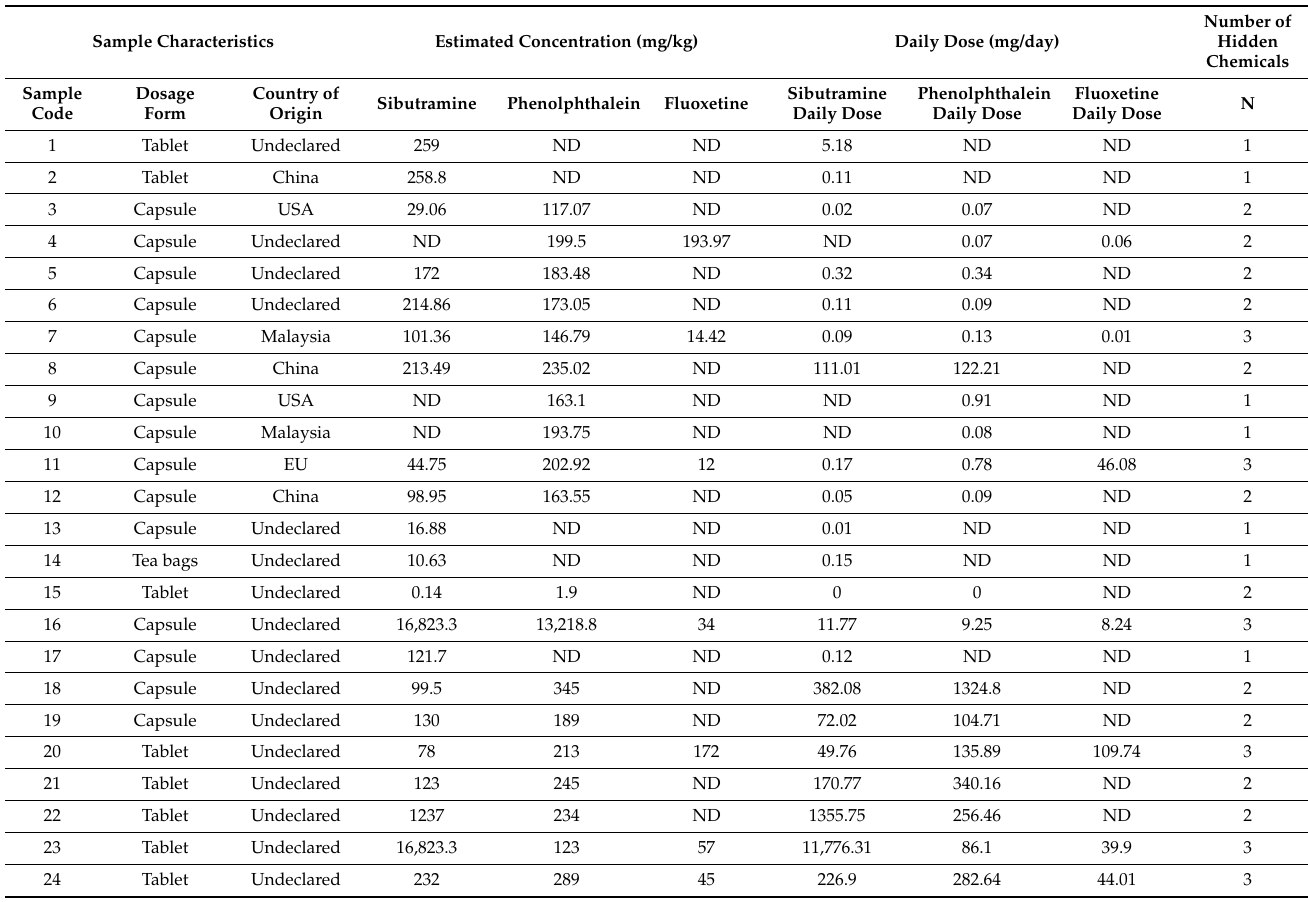
Table 4. List of tested weight loss supplement products according to the prescription drugs/chemicals and sample